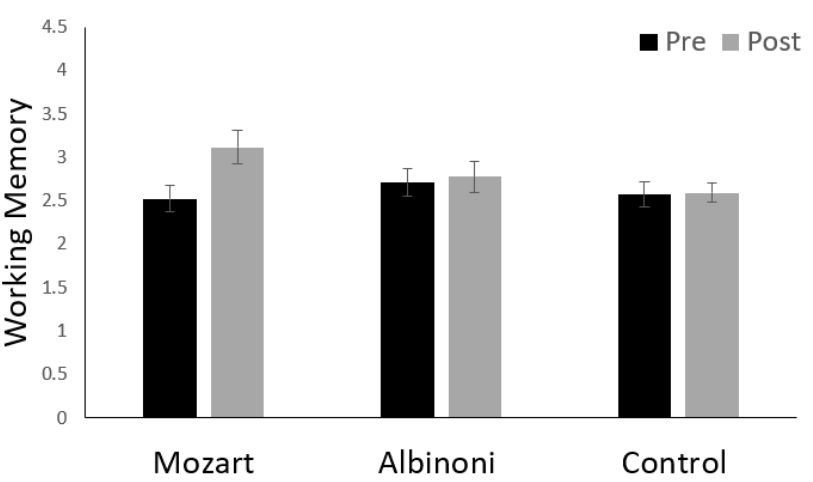
Figure 2. Means at pre- and post-test for scores for the test of working memory (WM). Higher scores indicate better WM. Error bars are SE s. The figure illustrates the two-way interaction between test session and listening condition: pre- to post-test improvements were evident only for the Mozart group.